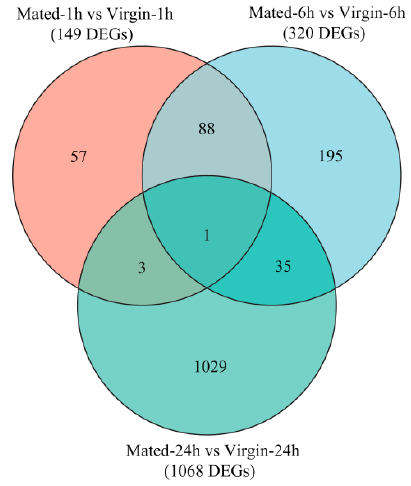
Figure 1. Volcano plots of the DEGs in Mated-1 h vs. Virgin-1 h group ( a ), Mated-6 h vs. Virgin-6 h group ( b ), and Mated-24 h vs. Virgin-24 h group ( c ). Genes with significant differential expression were indicated by red dots (upregulated) and green dots (downregulated). Genes with no significant differential expression were represented by grey dots.